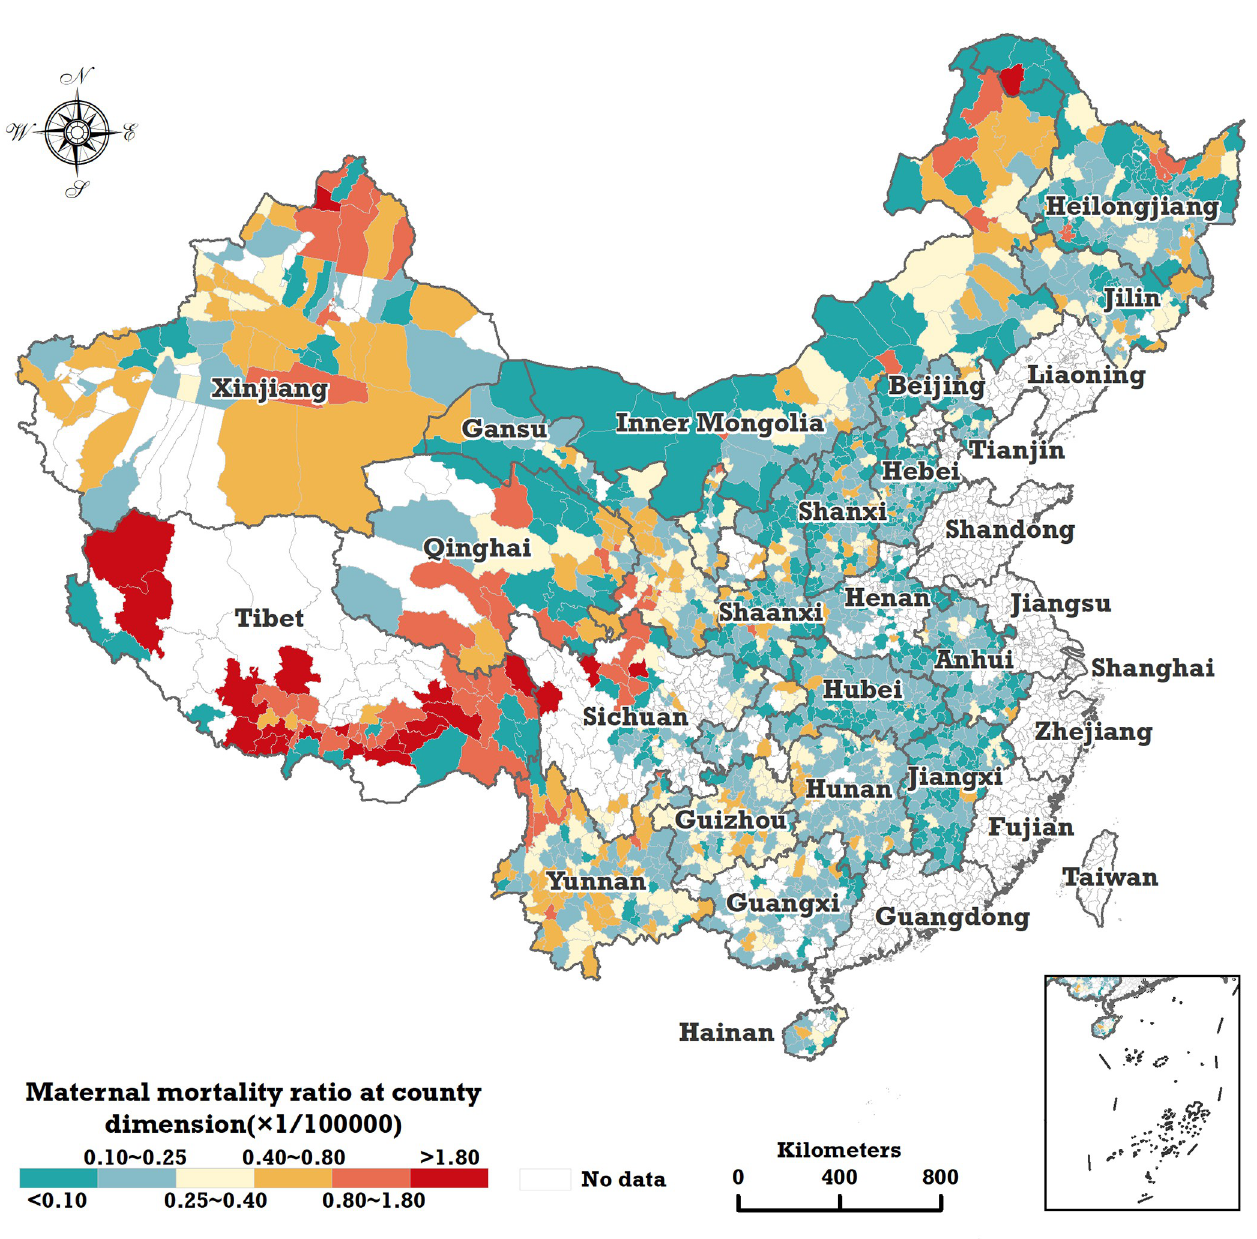
Fig 2. Spatial distribution of the mean MMR in 1,832 counties in China from 2010 to 2013. MMR, maternal mortality ratio.